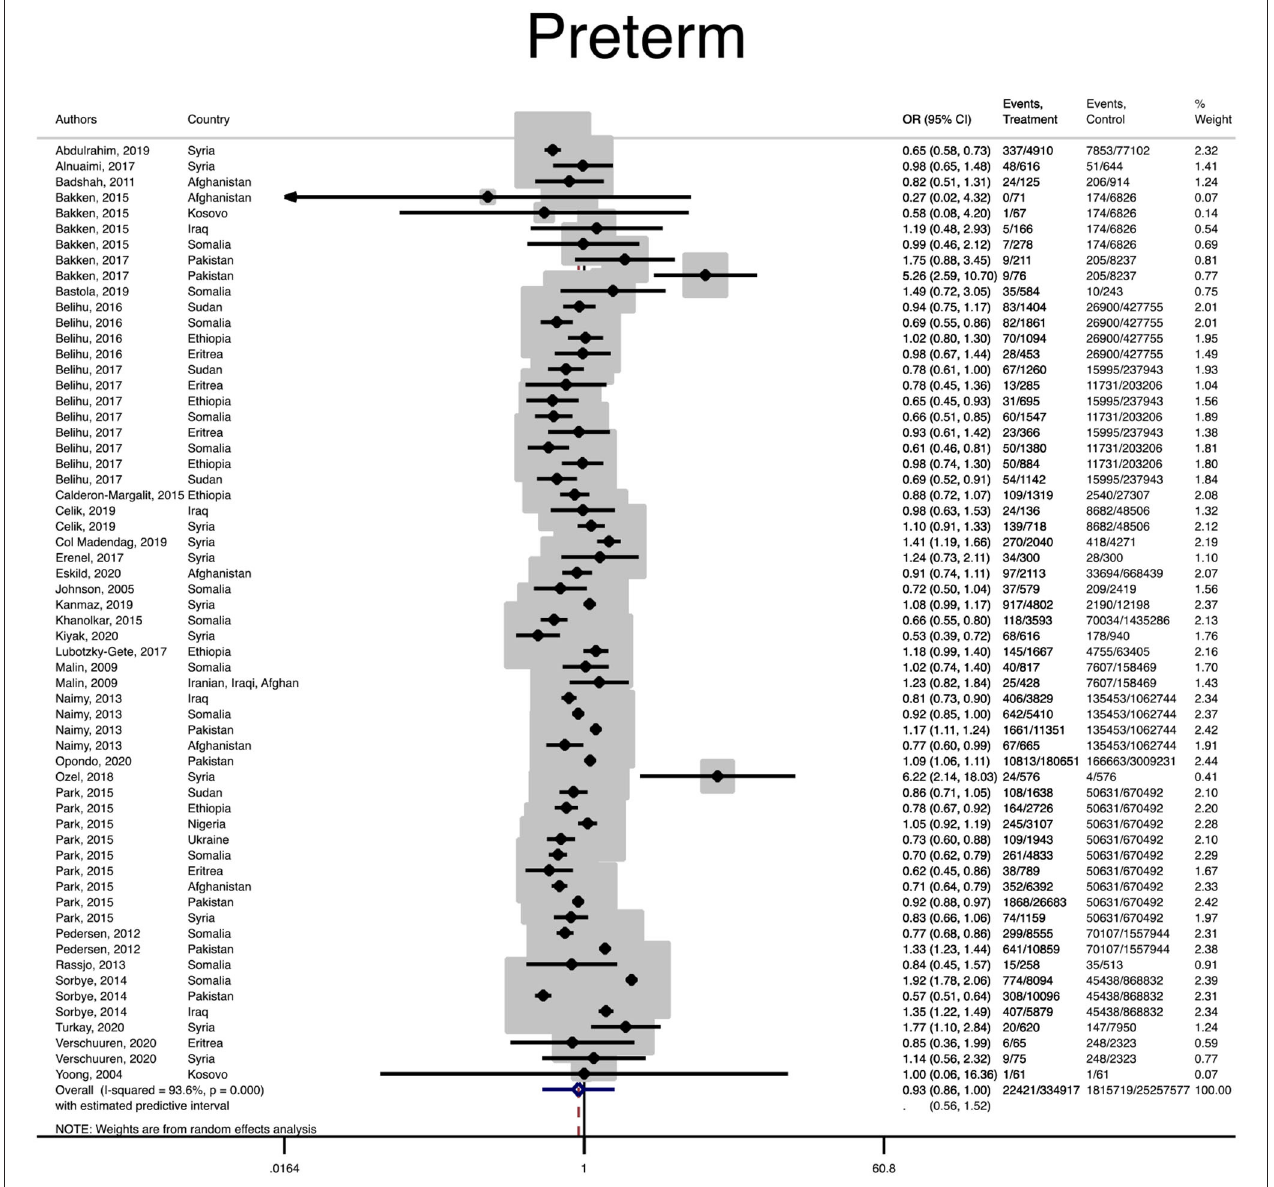
FIGURE 8 | Forest plot of the pooled odds ratio of preterm birth in the immigrant and native-origin